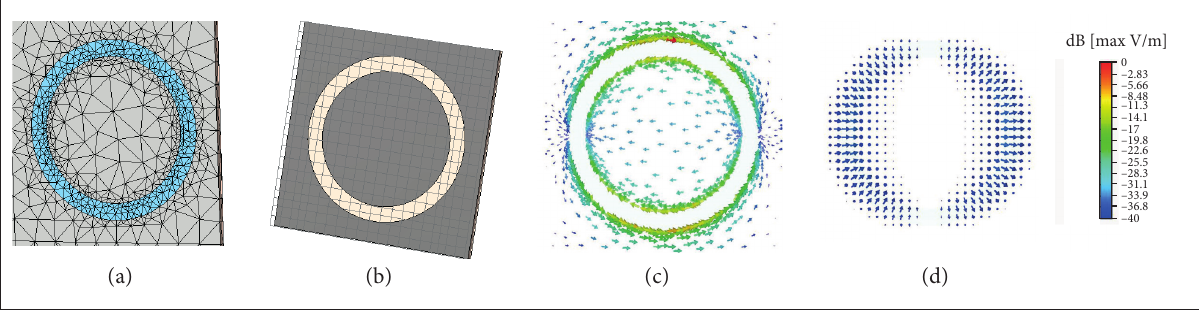
Figure 3. Meshes for the FEM (a) and FIT (b). Simulated surface current (c) and electric fi eld (d) for the resonant frequency of 6 GHz — normal incidence.